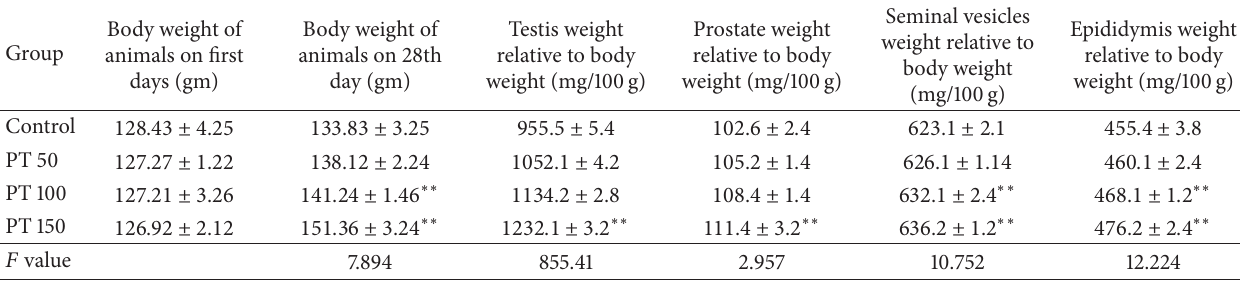
Figure 2: Effect of ethanolic extract of Pueraria tuberosa on histology oftestis. (a) Control group. (b) Ethanolic extract 50 mg/kg. (c) Ethanolic extract 100mg/kg. (d) Ethanolic extract 150mg/kg treated groups. F; fagellae; LC; Leydig cells; SG; spermatogonia; ST; spermatid. Table 2: Effect of ethanolic extract of Pueraria tuberosa on body and sexual organ